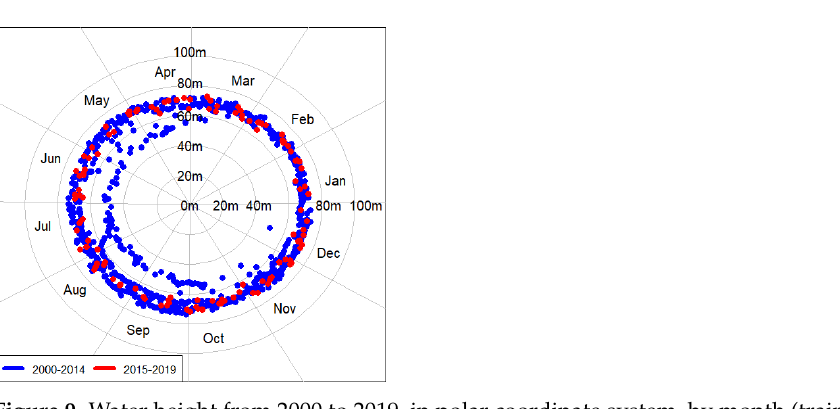
Figure 8. Water height from 2000 to 2019, by month (training set: from 2000 to 2014 and predicted set: from 2015 to 2019).